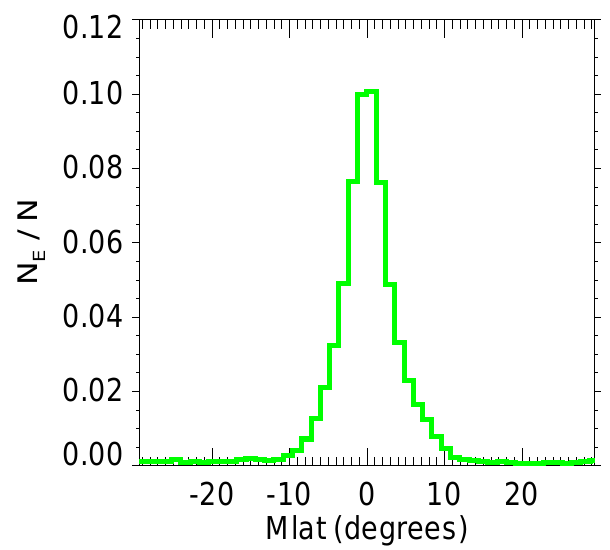
Fig. 7. The same as in Fig. 4b, but with the additional selection cri- terion of the magnetic spectral density larger than 10 − 6 nT 2 Hz − 1